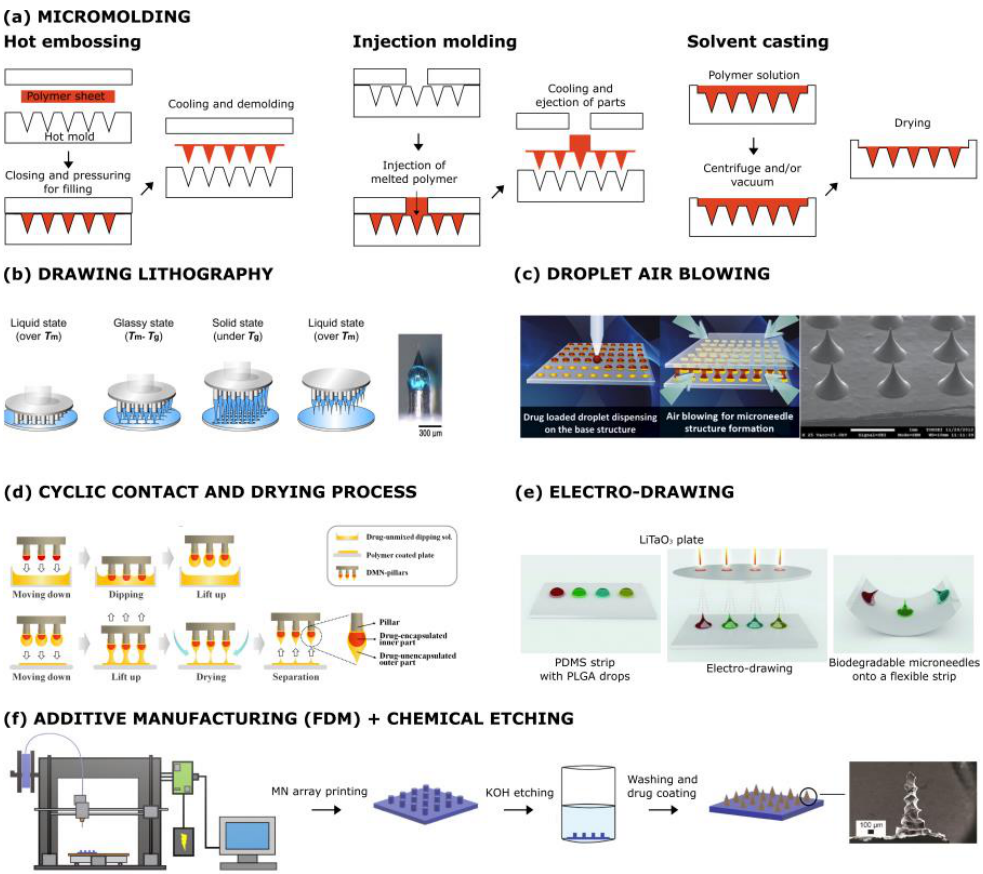
Figure 1. Microneedle (MN) manufacturing methods. ( a ) Micromolding: The mold with the desired MN structures can be filled with polymers by hot embossing, injection molding, or solvent casting. ( b ) Drawing lithography: The polymer is melted, dispensed on a fixed plate, and elongated by pillars in the upper-moving plate. ( c ) Droplet air blowing: Two plates, with polymer drops within, are contacted and then moved. When the final distance between the plates is reached, the polymer is hardened by means of air blowing. ( d ) Cyclic contact and drying: Pillars are repeatedly contacted with a drug-polymer solution, lifted, and dried with air blowing. ( e ) Electro-drawing: A thermal stimulus is applied to a pyroelectric crystal, generating an electric field which drives the microneedle drawing process. ( f ) Fused deposition modeling (FDM) of biodegradable polymer MNs: FDM is followed by KOH etching to improve feature size. Reprinted with modification from